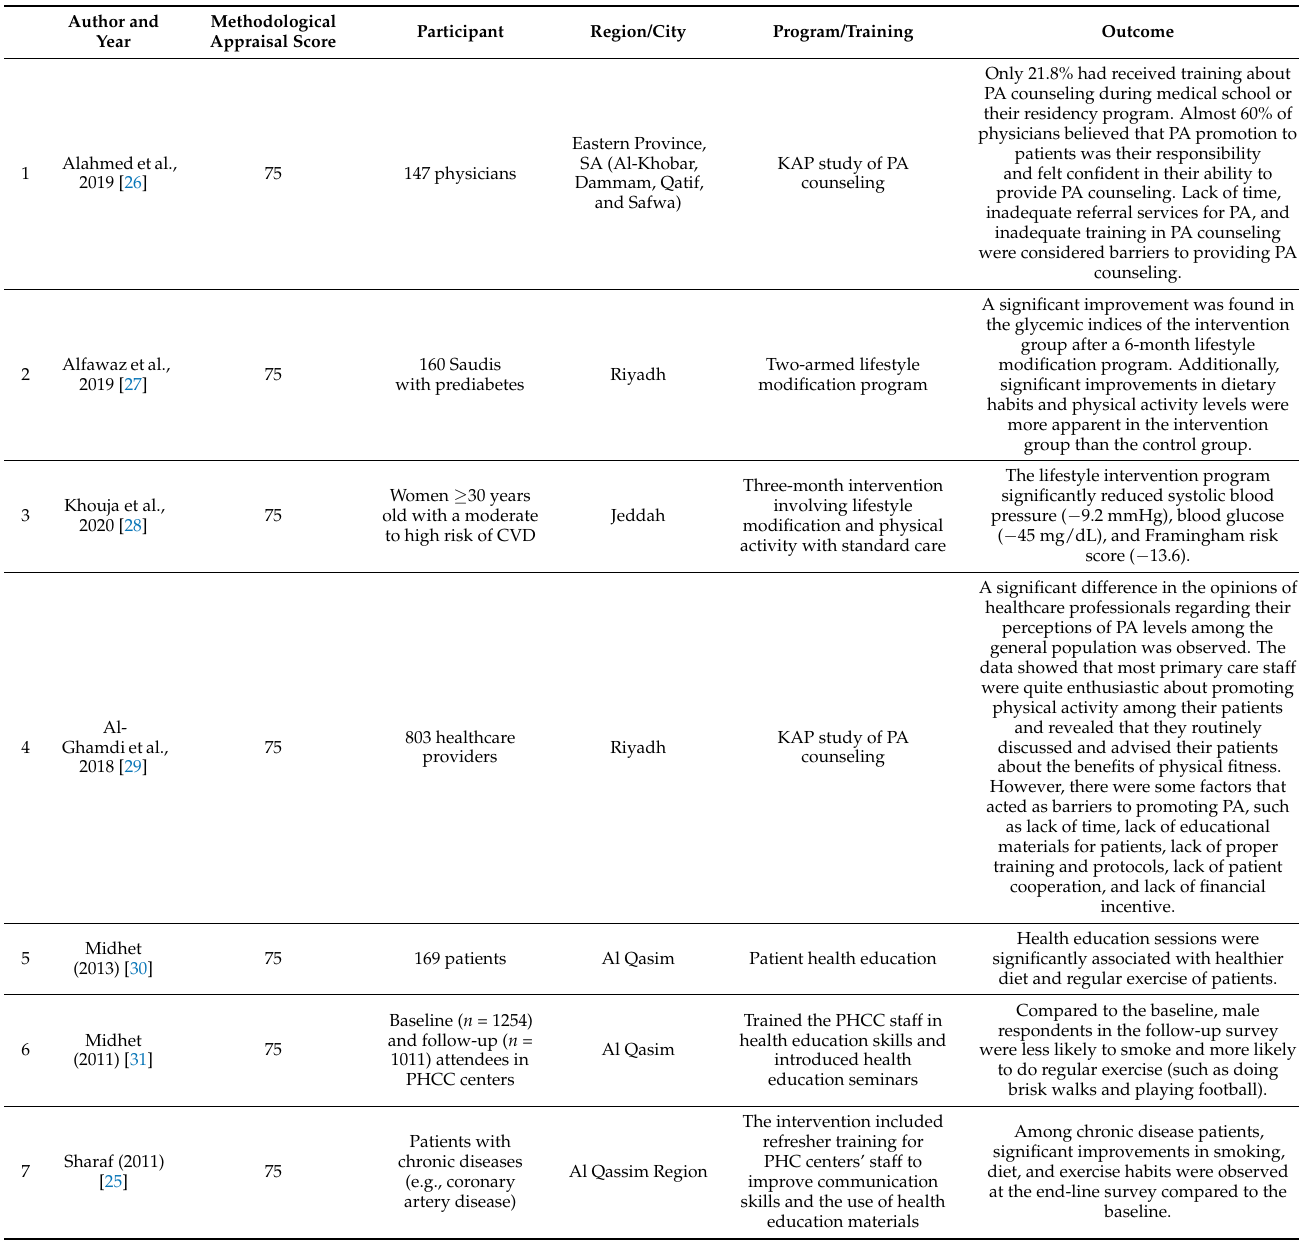
Table 1. Characteristics and outcomes of included